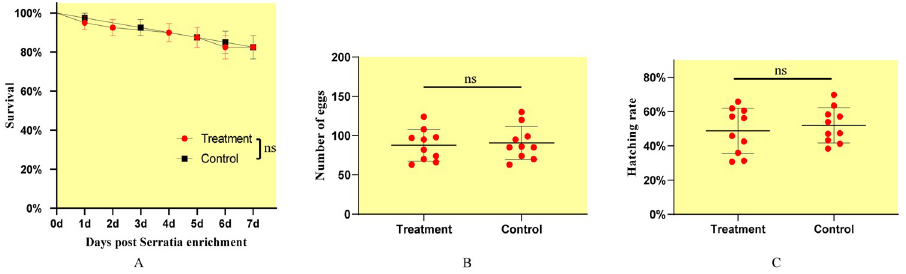
Fig 3. Treatment and control represent Serratia oryzae -enrichment and untreated mosquitoes, respectively. Serratia oryzae -enrichment in Aedes albopictus ’ guts cannot affect the survival rate (A), number of eggs laid (B), and hatching rate (C).